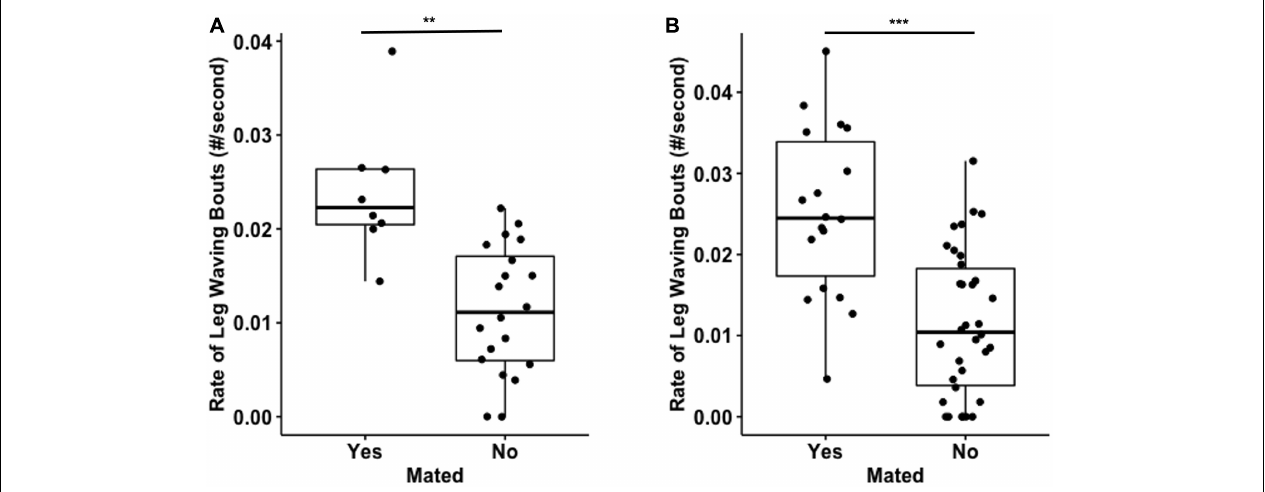
FIGURE 4 | Mating males displayed higher rates of leg waving bouts. The rate of leg waving bouts by males that mated was significantly higher than by males that did not mate in Experiment 1 ( A , ** p < 0.01) and in Experiment 2 ( B , *** p <